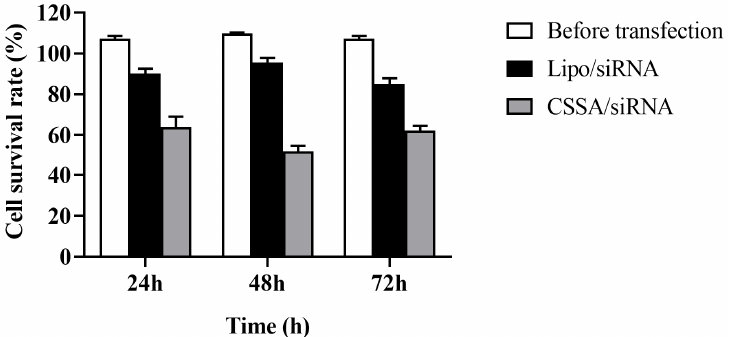
Figure 5. The cell survival rate underwent 5 Gy of X-ray radiation during different culture time (n = 3).